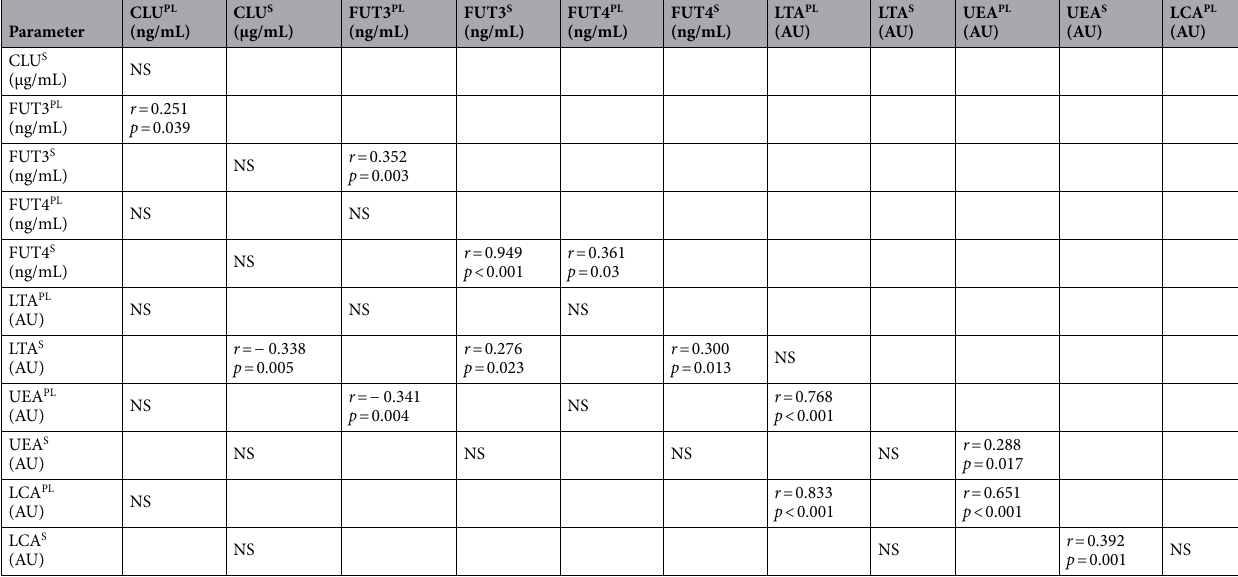
Table 2. The correlations between values of analyzed parameters. CLU PL —seminal plasma CLU concentration; CLU S —serum CLU concentration; FUT3 PL —seminal plasma FUT3 concentration; FUT3 S —serum FUT3 concentration; FUT4 PL —seminal plasma FUT4 concentration; FUT4 S —serum FUT4 concentration; LTA PL —